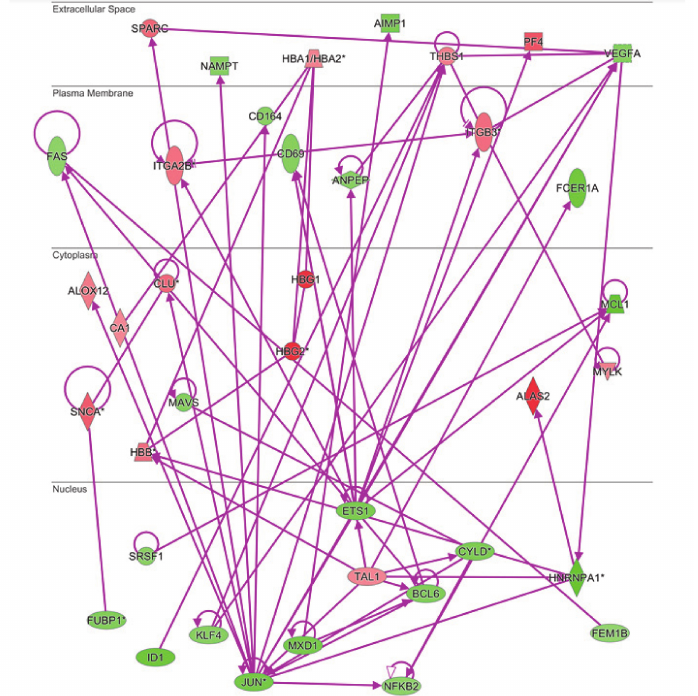
Figure 5. Connectivity of differentially expressed genes in the context of inflammation network. The * indicates genes identified by more than one probe in the